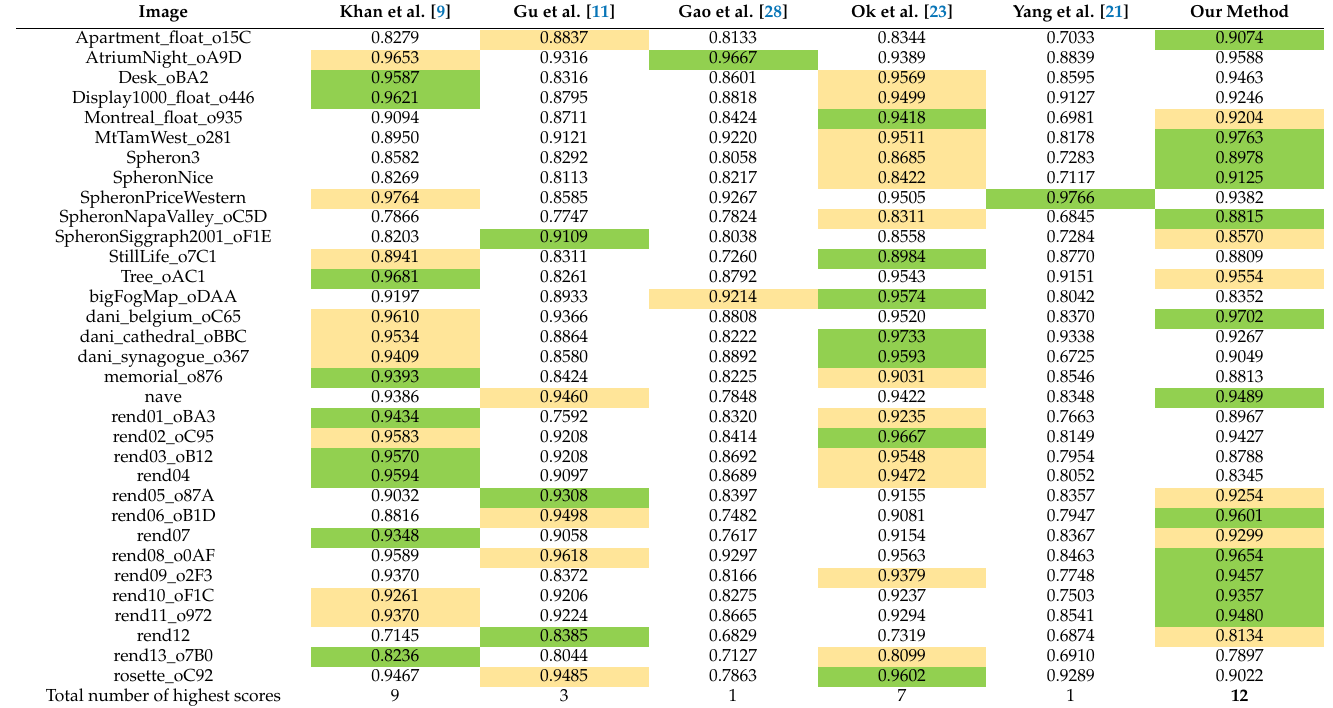
Green (and Yellow) numbers indicate the best (and the second-best) performing methods for each row,